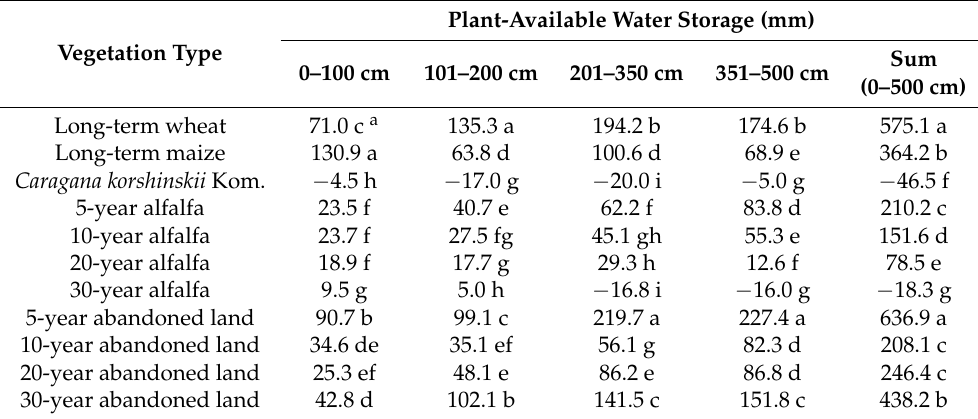
Table 2. Effect of land use on plant-available water storage in different soil profiles.